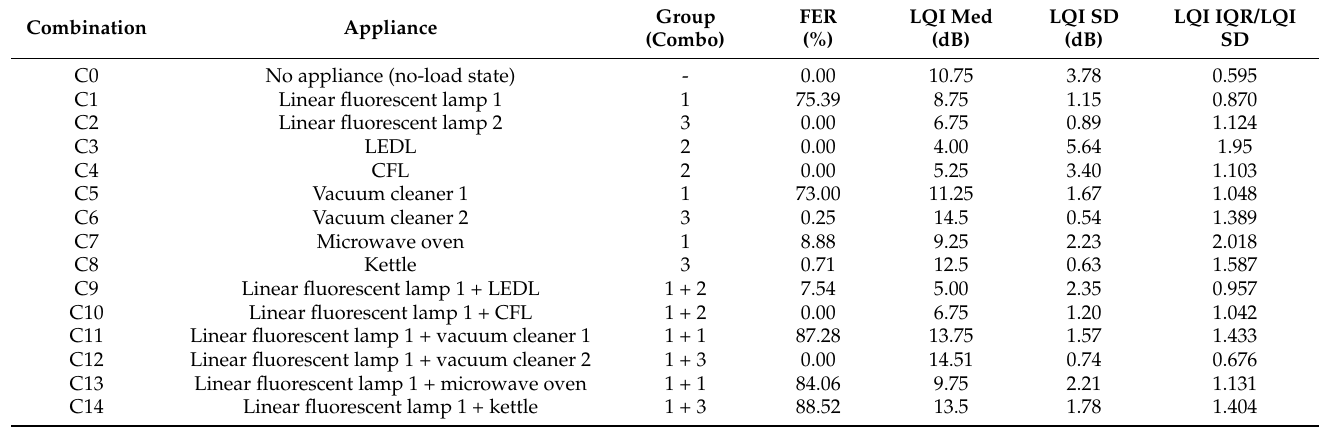
Figure 6. Signal attenuation measured at the receiver in the function of frequency band. Table 4. Combination used to test PLC and results from tester tool (Med = median, SD = standard deviation, IQR = interquartile